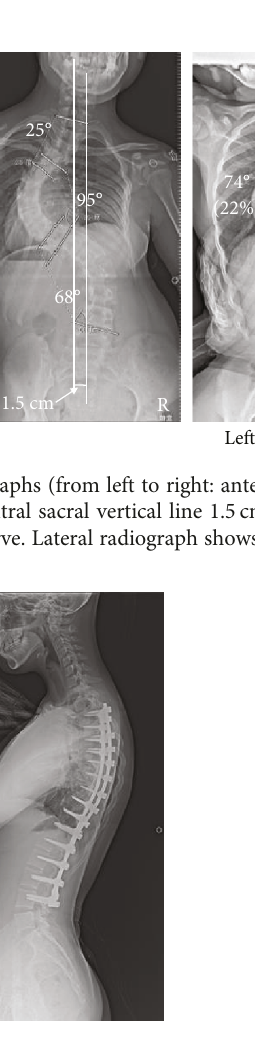
Figure 4: Case 2: radiographs (anteroposterior, lateral) 2 years after surgery show adequate curve correction and